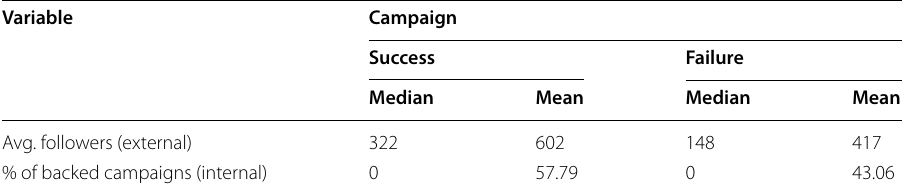
Table 4 Comparison of online followers and previous support for fundraiser